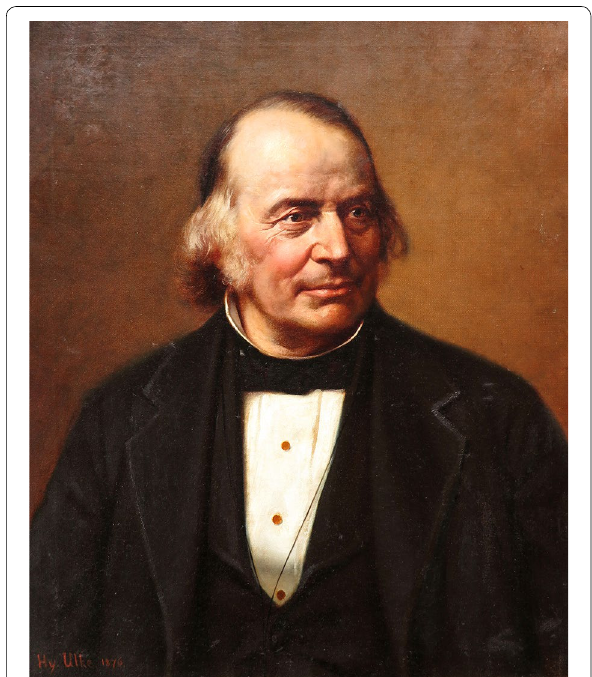
Fig. 1 Posthumous portrait of Louis Agassiz by Henry Ulke (oil on canvas), signed and dated (1876) in lower left-hand corner, after restoration (ex Ulke Family Collection, Swann 2013, sale 2324, lot 328, in part); courtesy of ERB